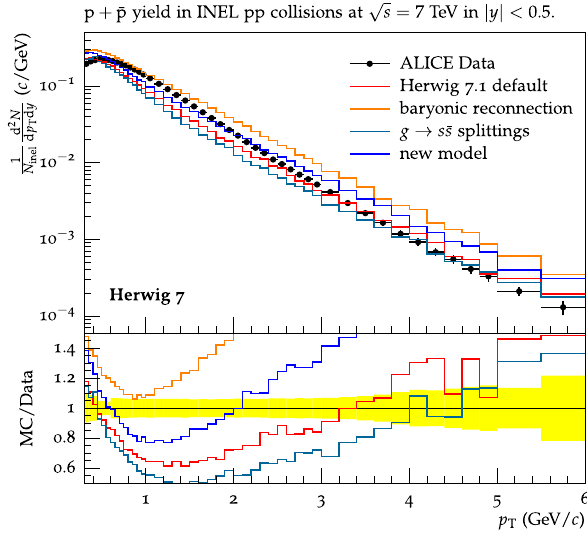
Fig. 8 The transverse momentum spectrum for p + ¯ p as measured by √ s = 7TeV [25] in the very central rapidity region | y | < 0 . 5 ALICE at